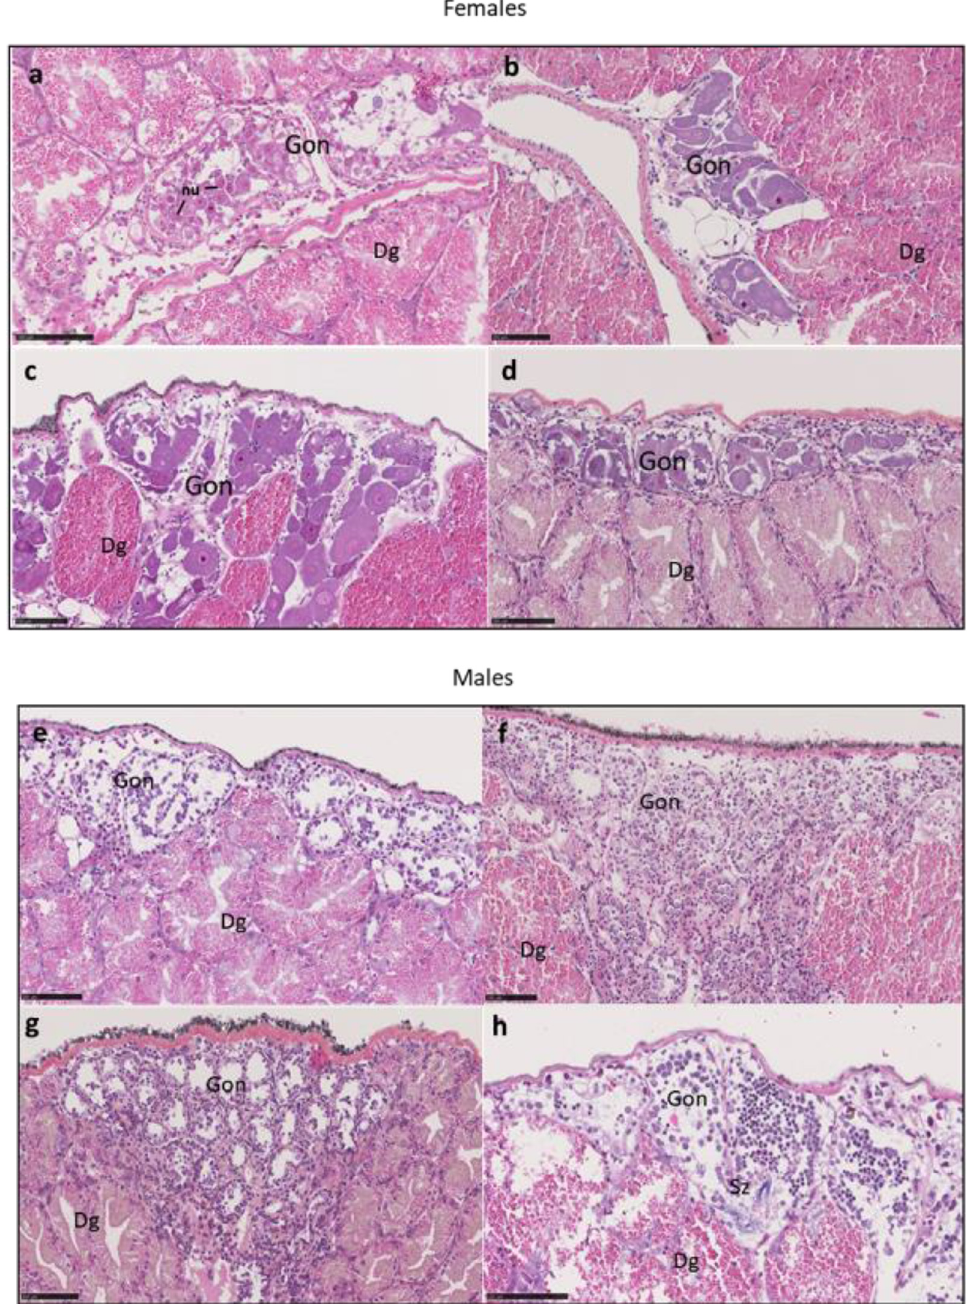
Fig. 4. T. mutabilis . Histological sections of the gonads of small ( (cid:3) 20 mm) male and female specimens. (a to d): female with increasing shell length (a 10 mm, b 14 mm, c 16 mm, d 18 mm) (e to h), male with increasing shell length (e 13 mm, f 14 mm, g 16 mm, h 17 mm). Dg Digestive gland, Gon Gonads. nu nucleoli (two or three nucleoli are visible in (a) a 10 mm female), Sz Mature Spermatozoa. Scale bars = 100 m